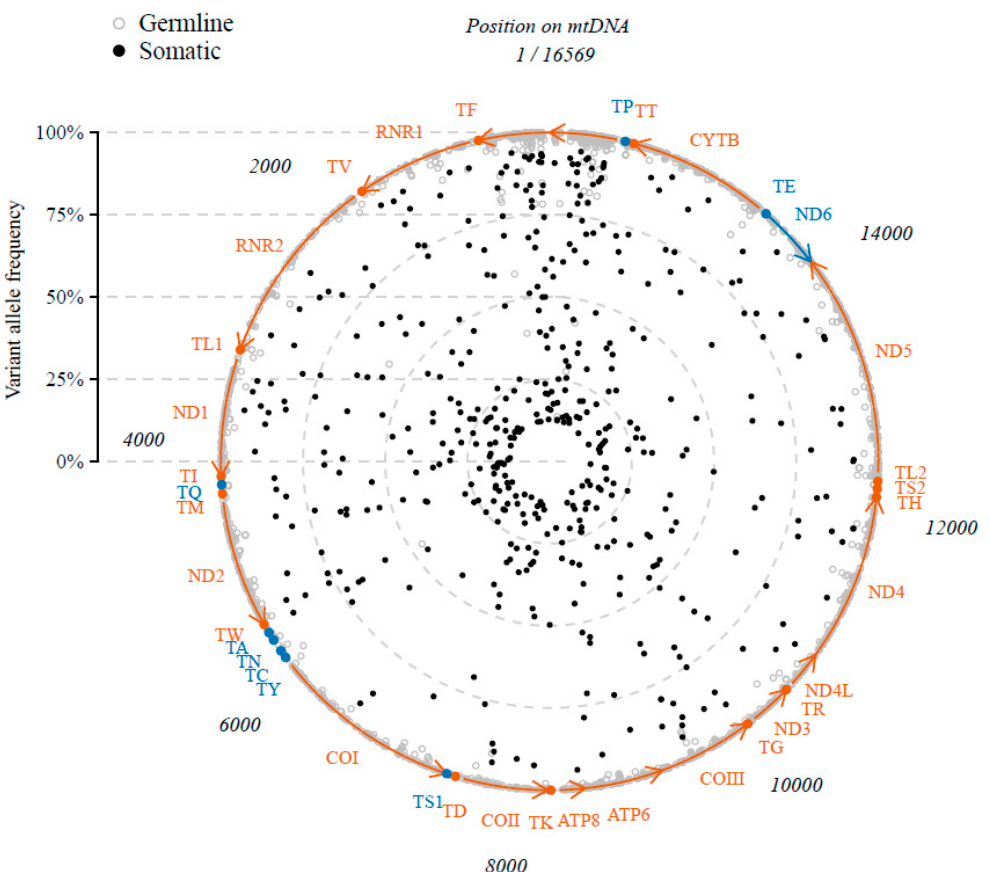
Figure 1. Variants in the mitochondrial RNA of 344 primary breast tumor cases. Position on the mitochondrial genome (circle) and their variant allele frequency (increasing % from inner-to-outer) of all variants identified in the 344 cases. Somatic or germline origin in respectively closed black or open grey circles. Genes and their direction of transcription (arrows) in red (+strand) or blue ( − strand). Note that variants on position 2617 (known RNA - DNA differences) are not shown.